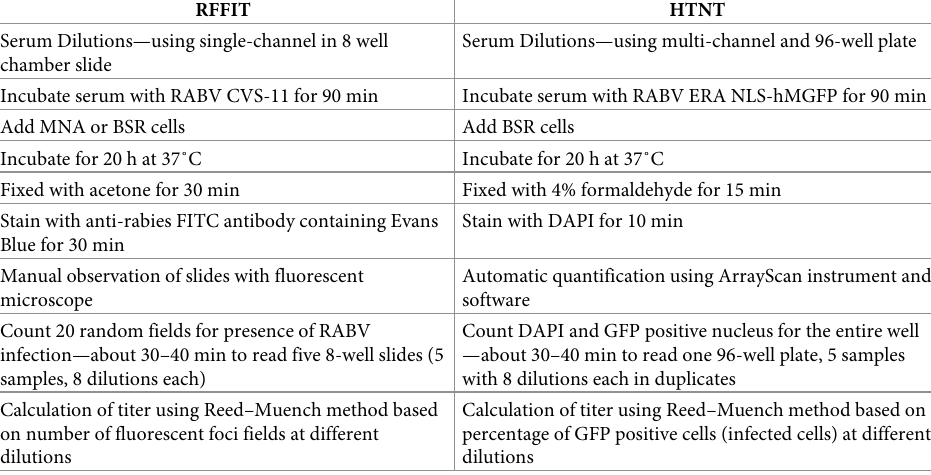
Table 1. Comparison of different steps involved in RFFIT and HTNT protocols. RFFIT HTNT Serum Dilutions—using single-channel in 8 well Serum Dilutions—using multi-channel and 96-well plate chamber slide Incubate serum with RABV CVS-11 for 90 min Incubate serum with RABV ERA NLS-hMGFP for 90 min Add MNA or BSR cells Incubate for 20 h at 37˚C Incubate for 20 h at 37˚C Fixed with acetone for 30 min Fixed with 4% formaldehyde for 15 min Stain with anti-rabies FITC antibody containing Evans Stain with DAPI for 10 min Blue for 30 min Manual observation of slides with fluorescent Automatic quantification using ArrayScan instrument and microscope software Count 20 random fields for presence of RABV infection—about 30–40 min to read five 8-well slides